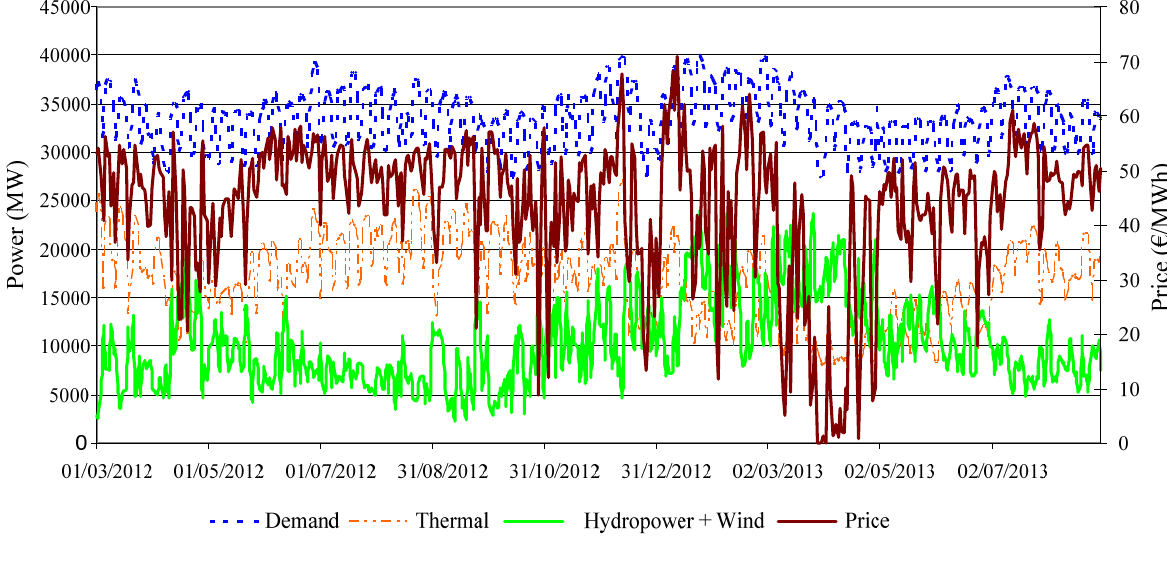
Figure 3. Evolution of the daily average prices and some explanatory variables along part of the years 2012 and